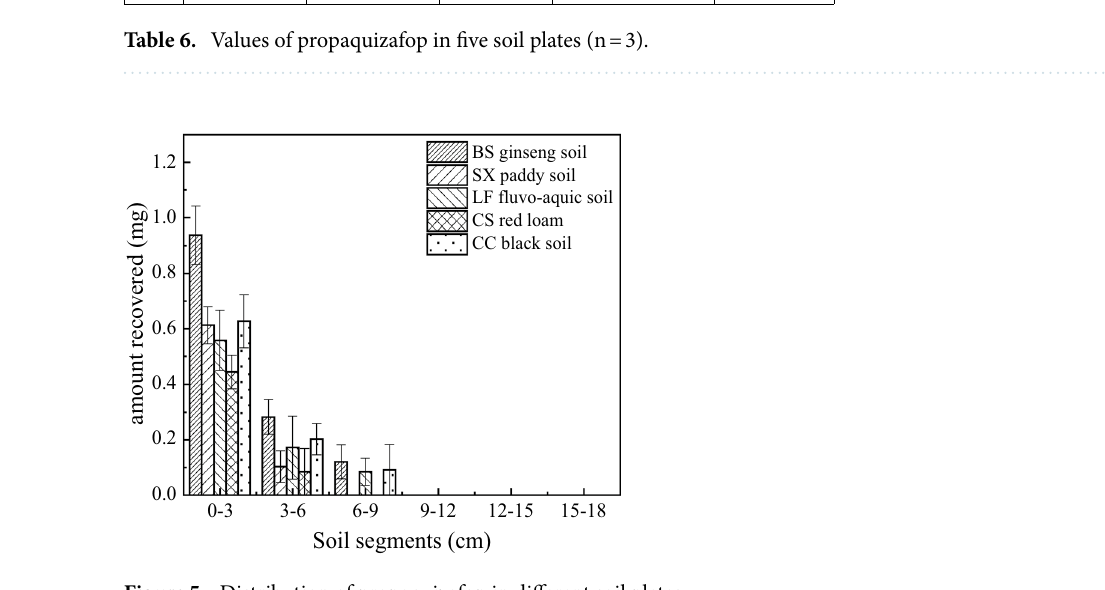
Figure 5. Distribution of propaquizafop in different soil plates.